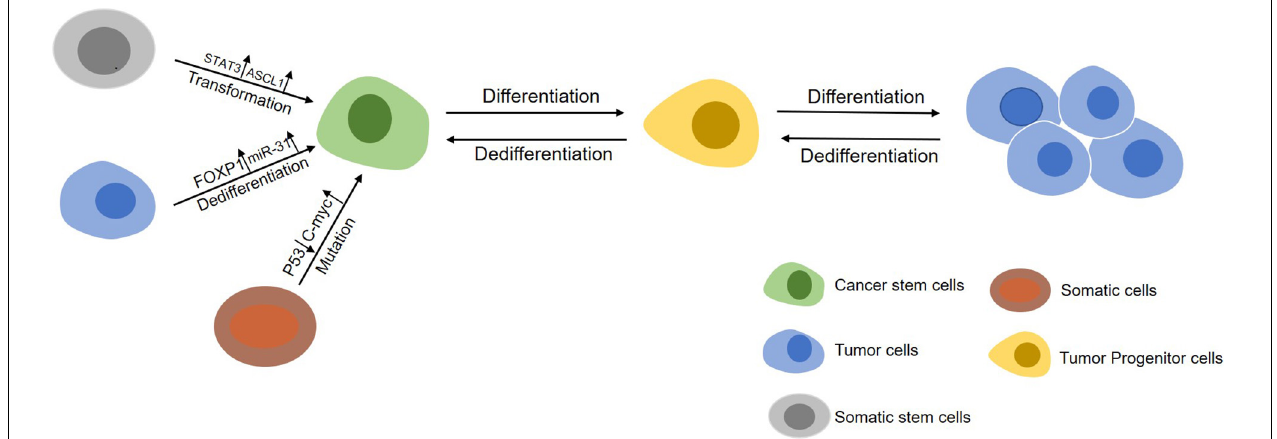
FIGURE 1 | An overview of the initiation of CSCs. Somatic stem cells (gray) can maintain self-renewal through symmetrical divisions. However, normal stem cells may transform into CSCs (green) under following circumstances including gene mutations occuring in cells during chromatin rearrangements and influence by factors in the tumor microenvironment. On the other hand, differentiated cancer cells (blue) can dedifferentiate into a cancer stem-like cells state by abnormal signal activation or induction from other cells in tumor